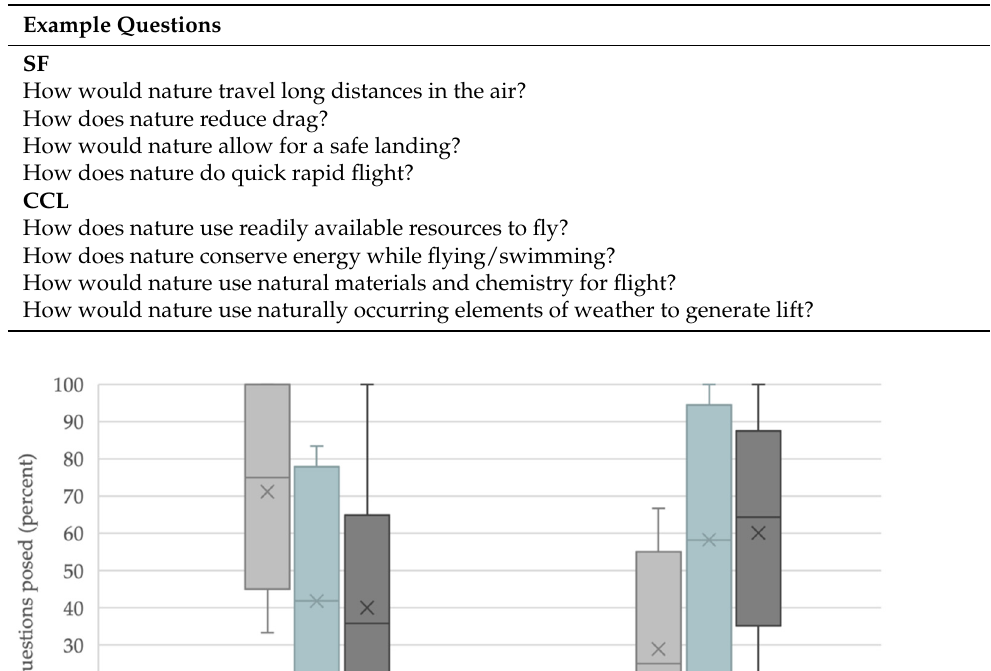
Table 1. Student design sprint question response examples and Structure-Function (SF) and Condi- tions Conducive to Life (CCL) classifications.